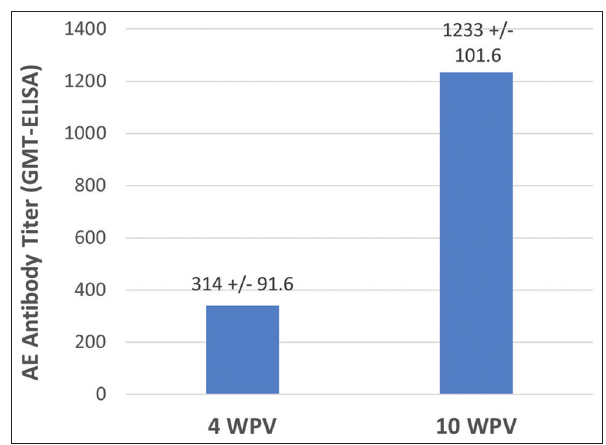
Figure-3: Avian encephalomyelitis antibody titer at 4 and 10 weeks post-vaccination in the field vaccinated chickens. Number of serum sample tested =